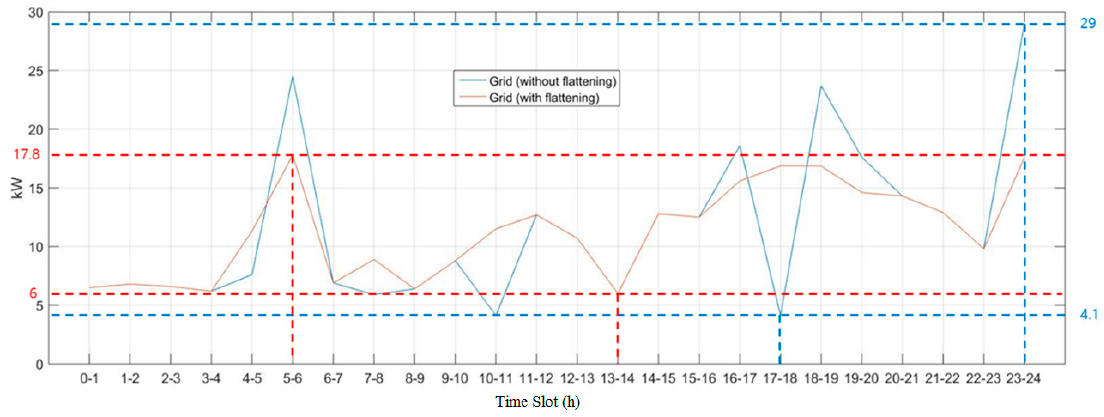
Figure 16. The result of the application of grid flattening condition.